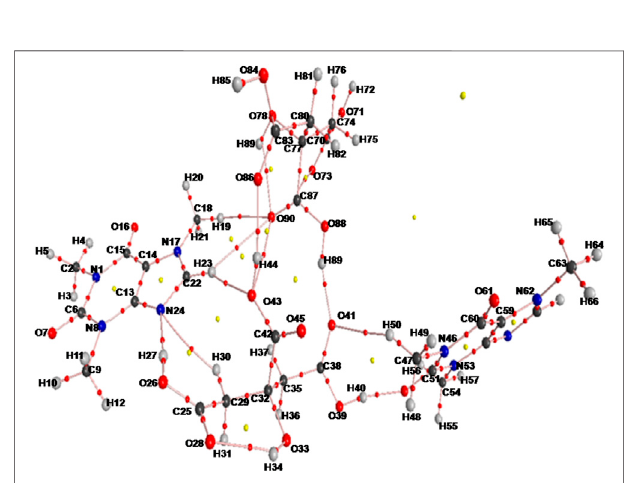
FIGURE 5 | Molecular graph of dimer model of cocrystal: BCPs (small red spheres), ring critical points (small yellow sphere), bond paths (pink lines).